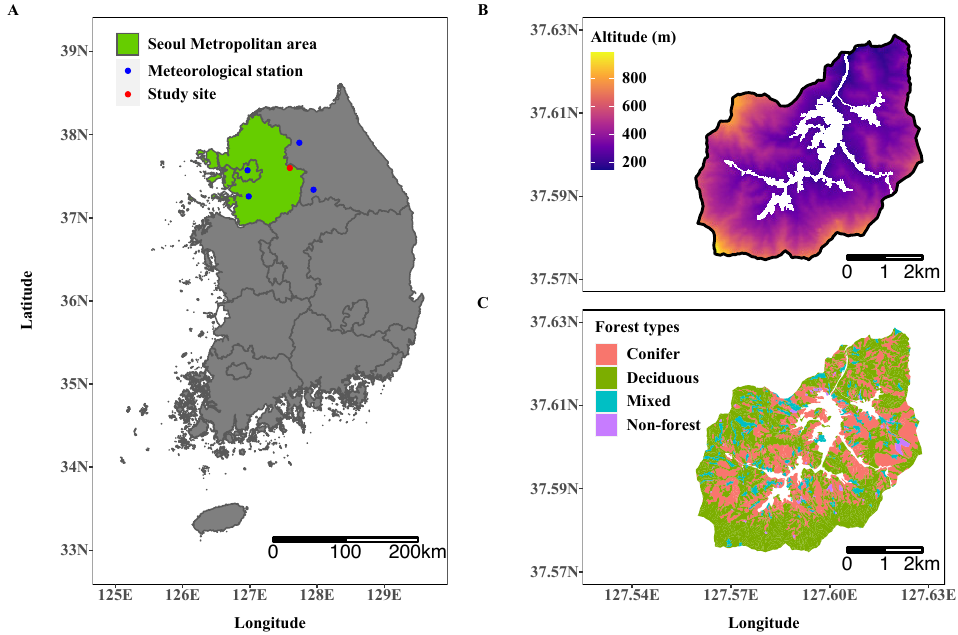
Figure 1. Location ( A ), topography ( B ), and forest types ( C ) of the study site (Saneum-ri). Blue points in ( A ) represent the meteorological stations near the study site providing solar irradiation